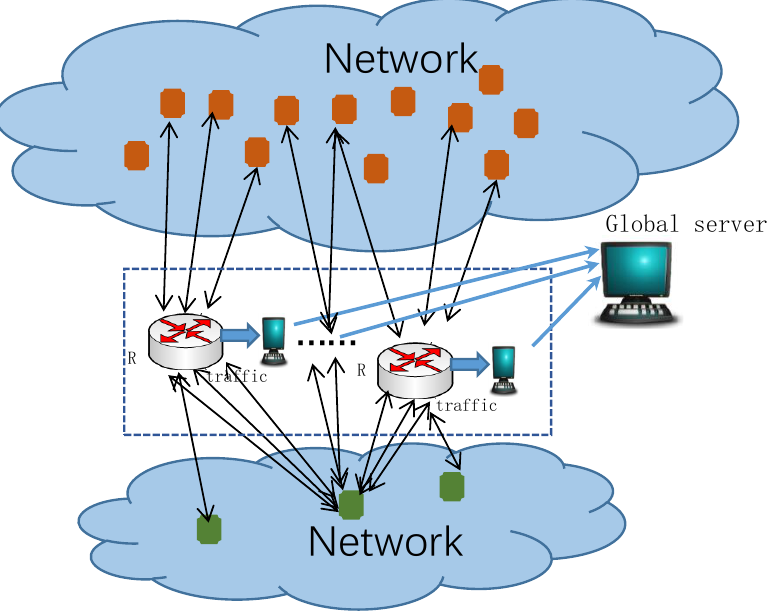
Figure 2. Super points detection in a distributed